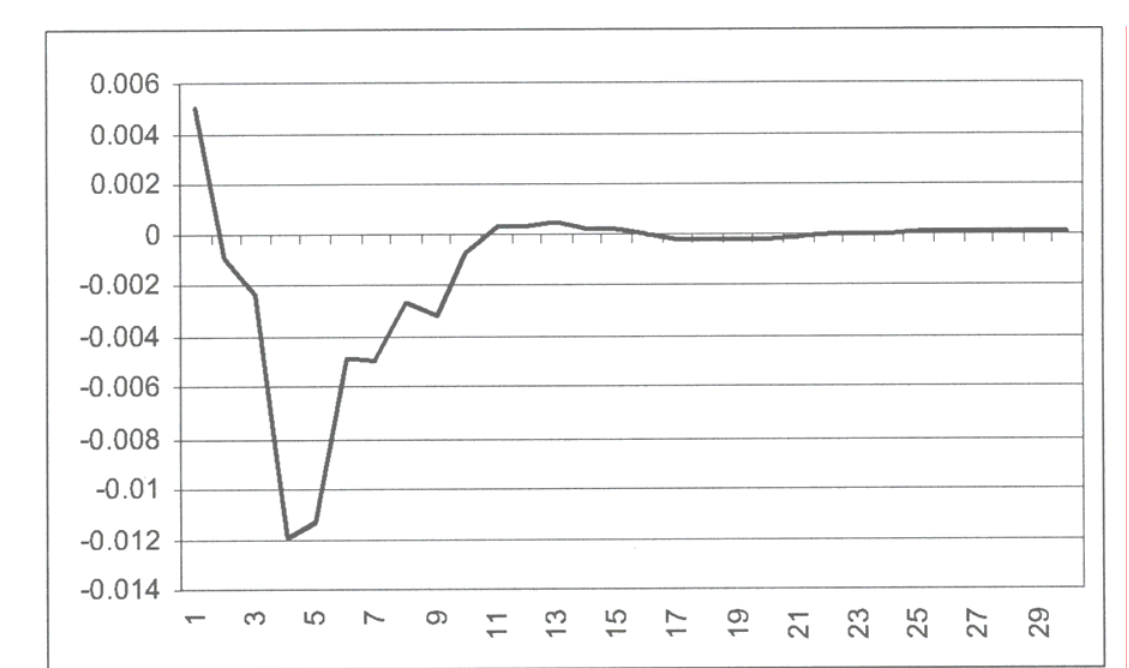
Impulse-response function of the yield